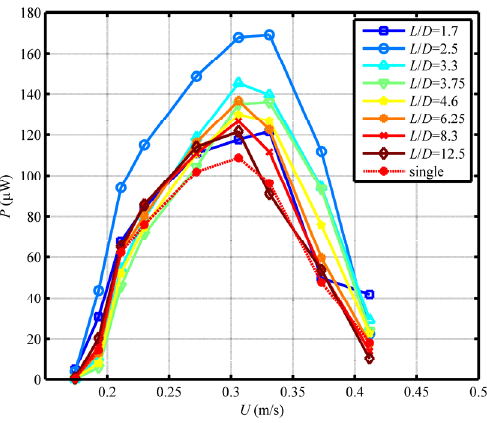
Figure 6. Output powers of the upstream harvester and the single one as a function of the water speed for eight different spacing ratios.